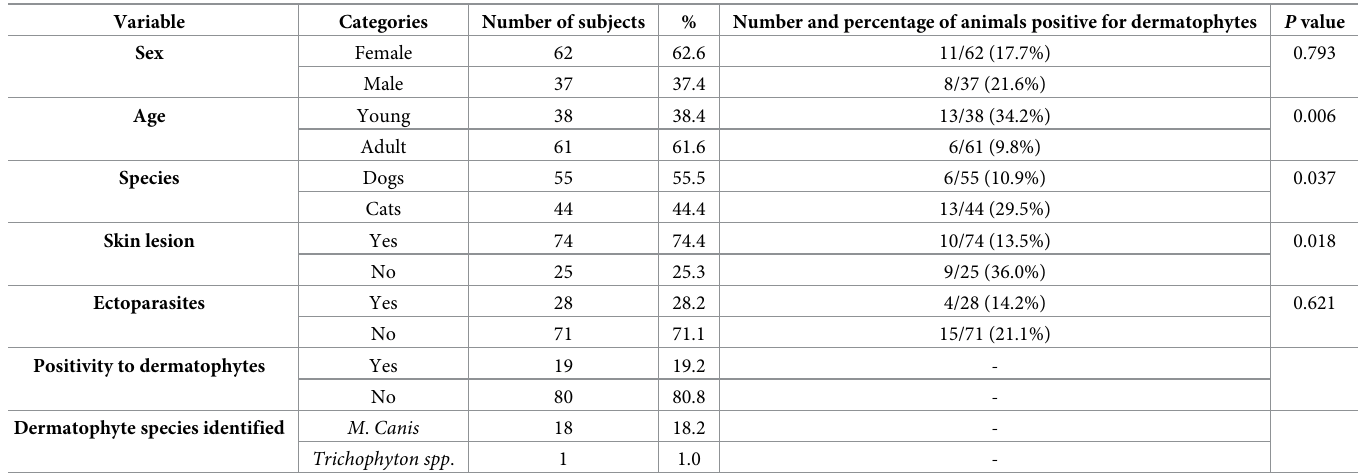
Table 1. Epidemiological